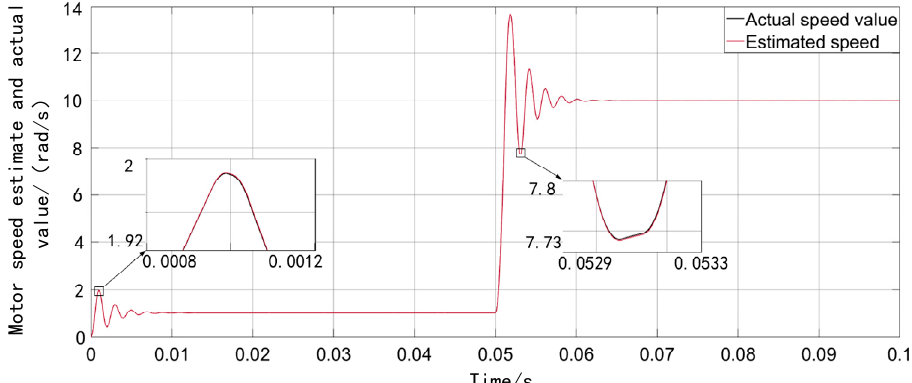
Figure 11. Comparison chart of motor speed of the new and improved SMO at low speed.